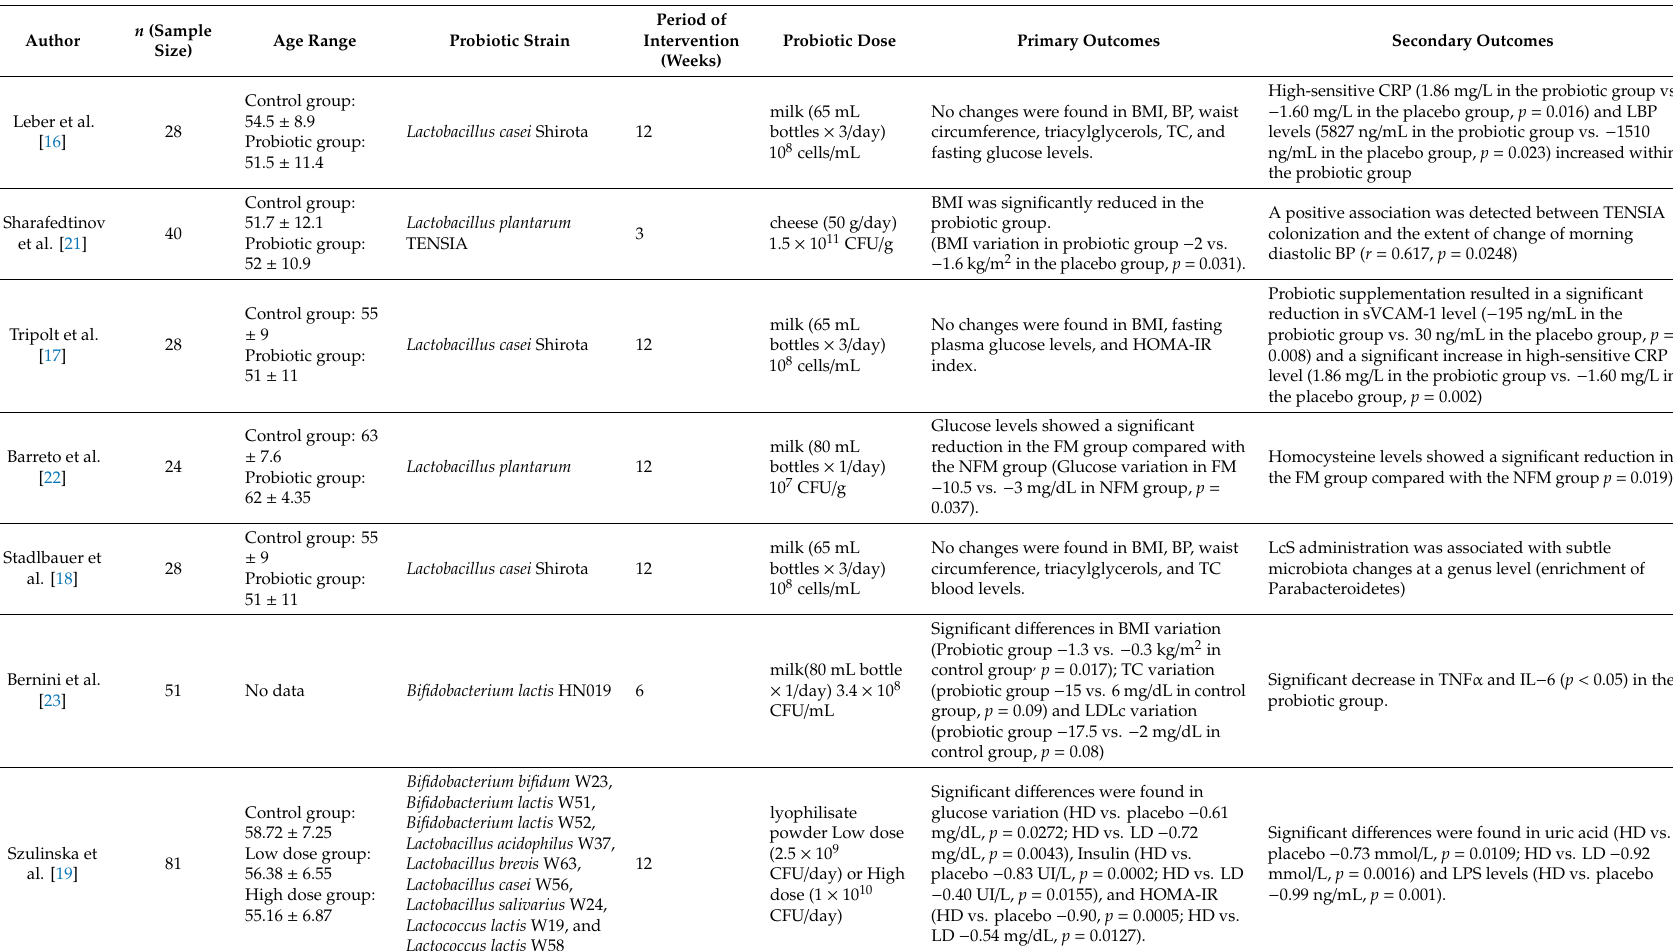
Table 2. Main characteristics of the nine included articles evaluating the e ff ect of probiotics on metabolic syndrome